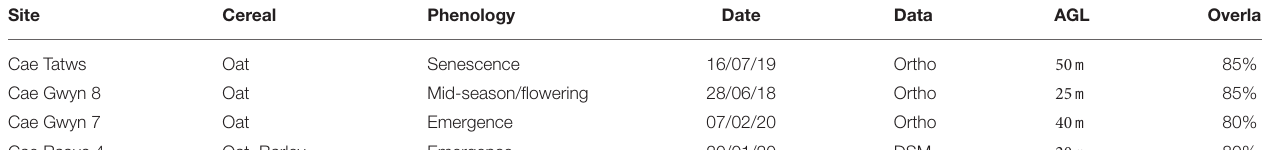
TABLE 1 | Study site names, cereal type, phenology, collection date, UAS-derived data type used, and flight height above ground level (AGL).